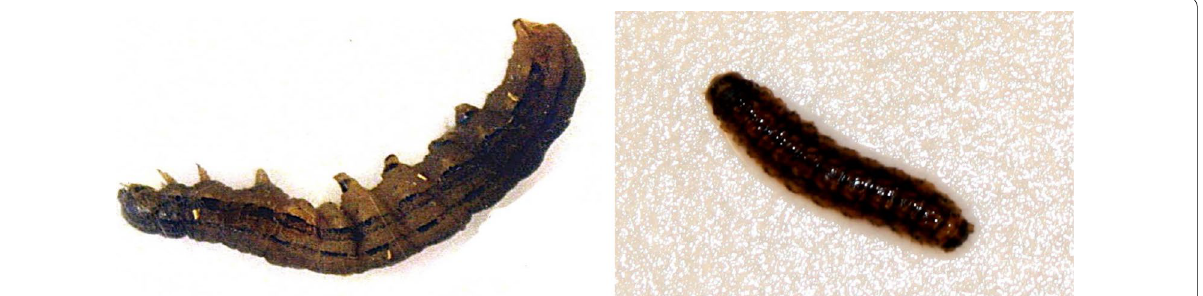
Fig. 2 Cutworm infected with entomopathogenic nematode, Steinernema